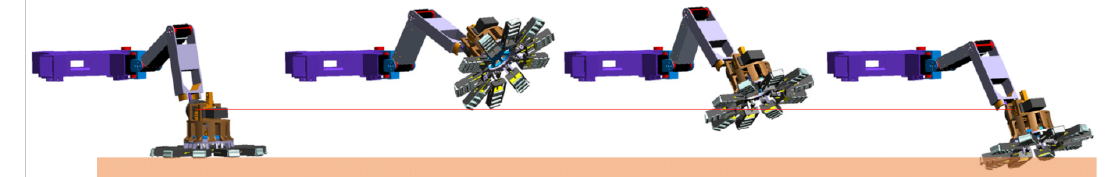
Figure 10. The motion process of the anchoring mechanism when